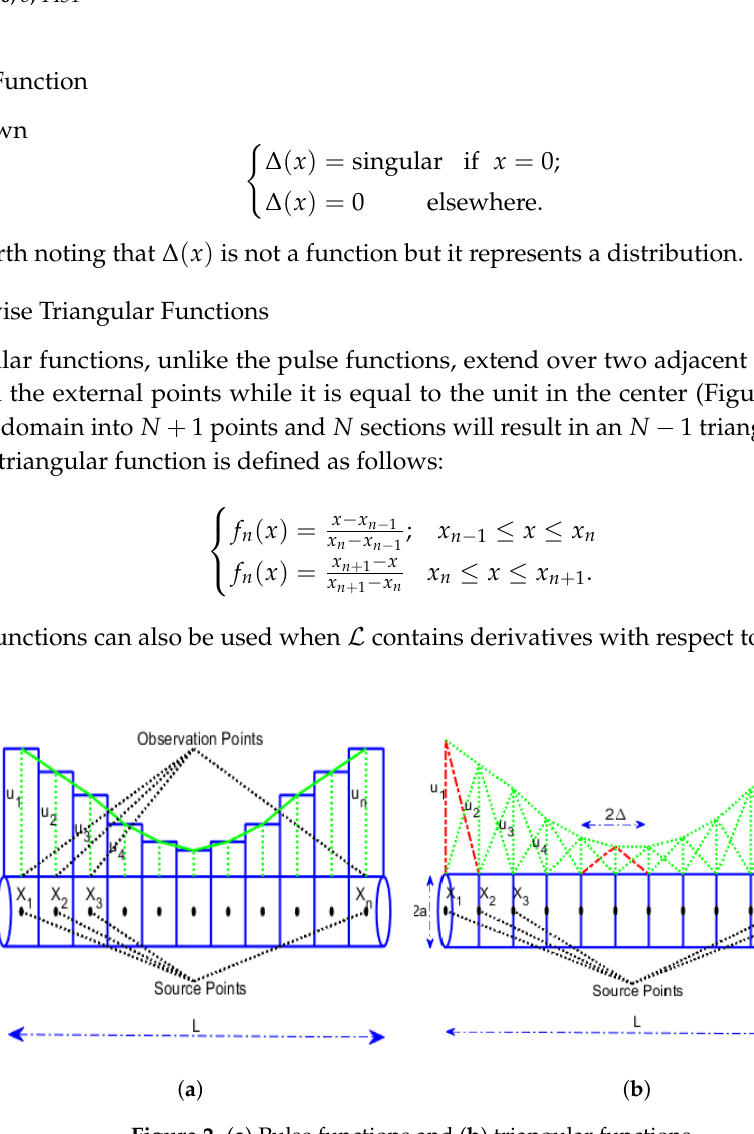
Figure 2. ( a ) Pulse functions and ( b ) triangular